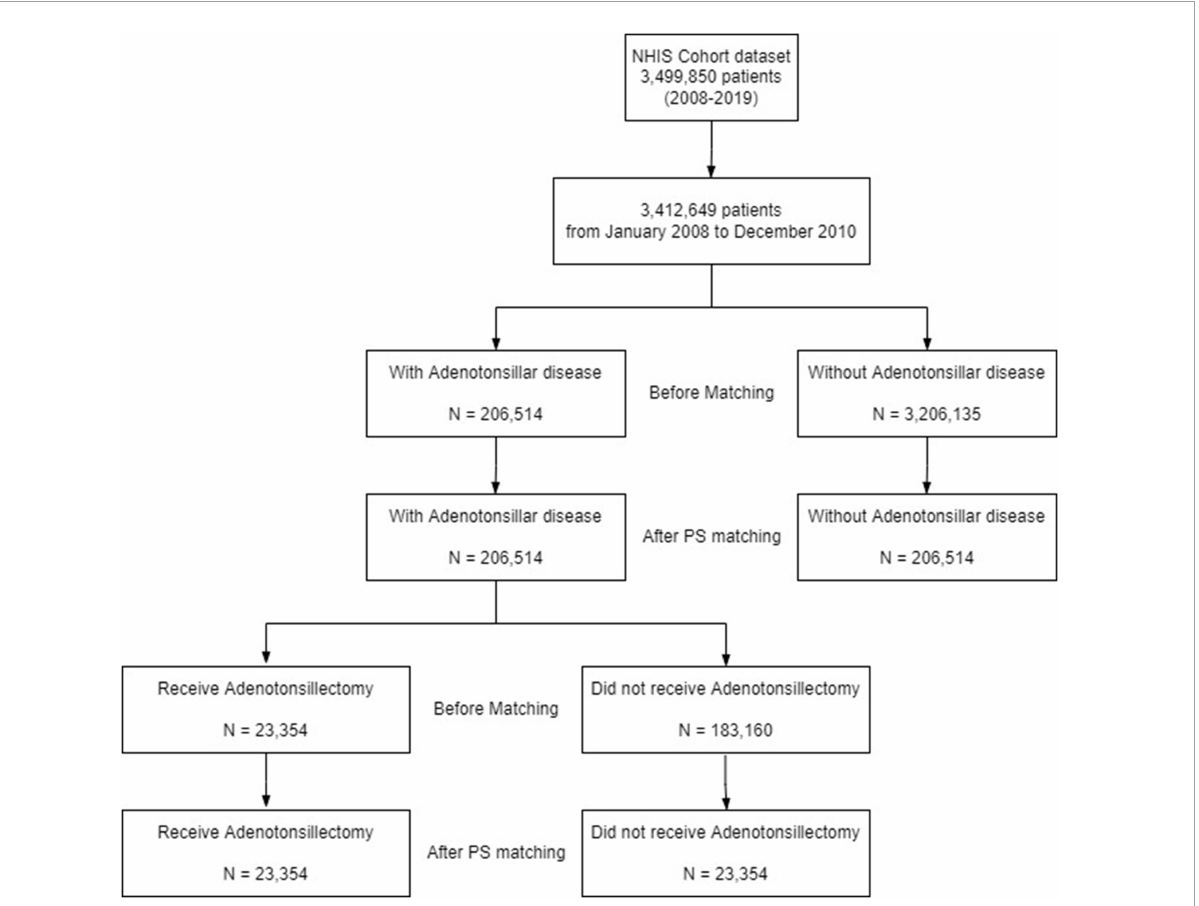
FIGURE1 Study flow chart. NHIS, National Health Insurance Service; PS, propensity score.